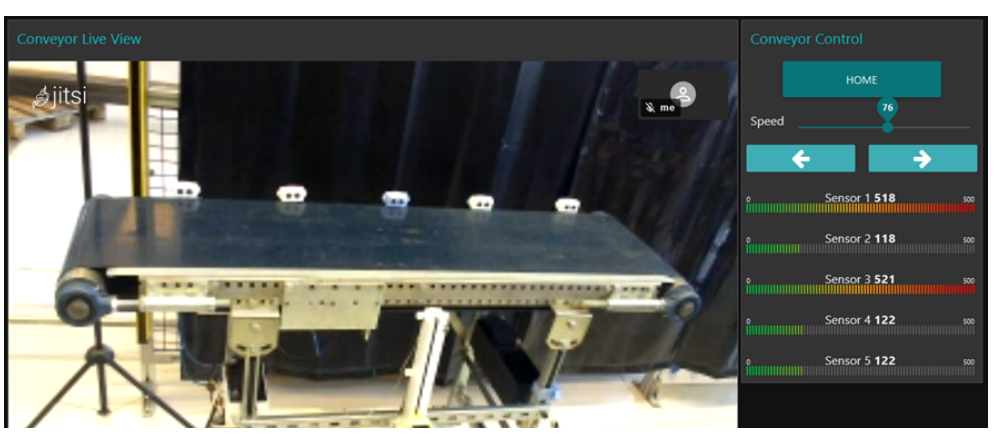
Figure 4. Control interface of conveyor with embedded live video